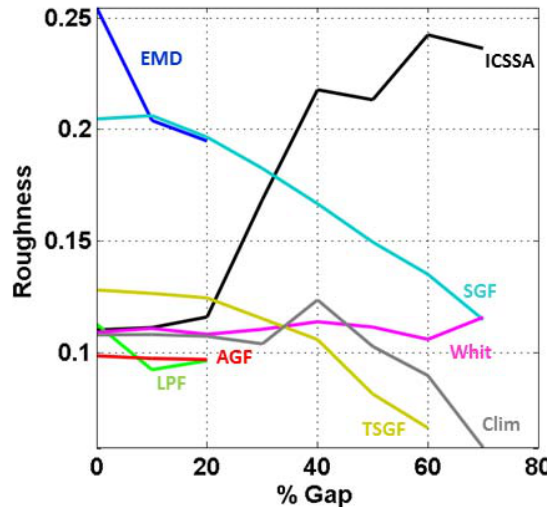
Fig. 9. Roughness of LAI rec as a function of %gap in LAI sim